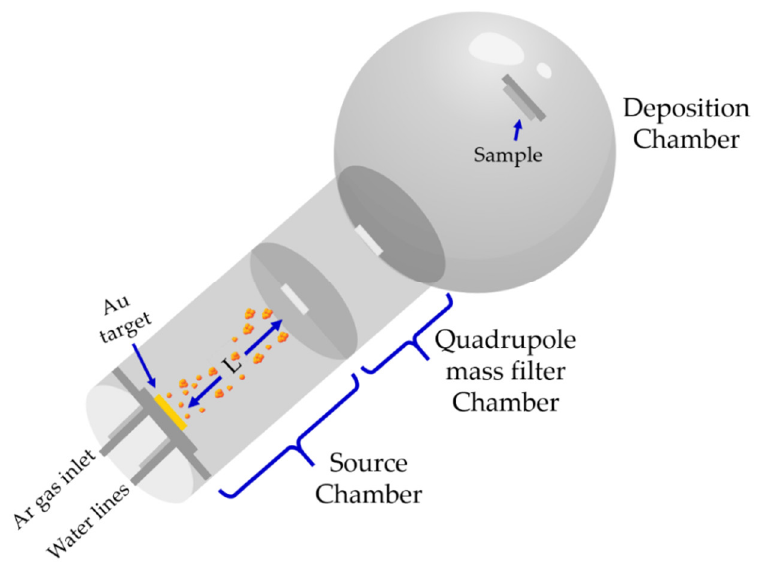
Figure 1. Schematic of the deposition system used in this study.